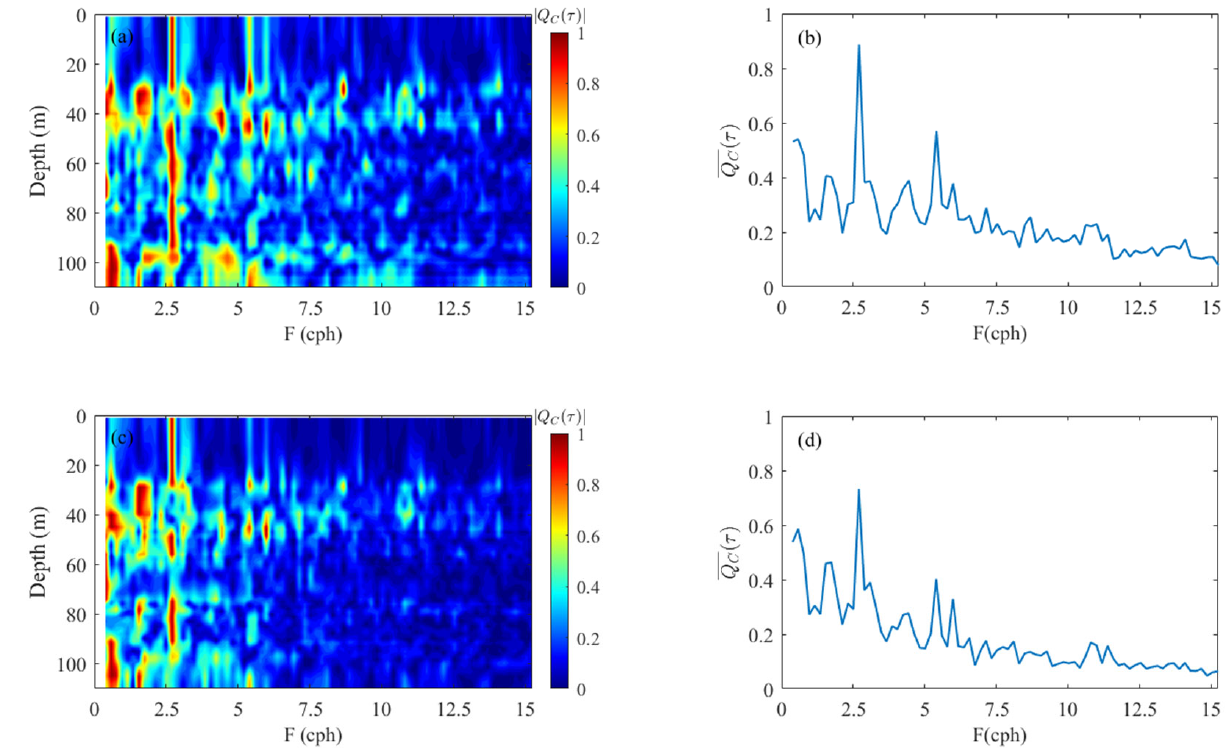
Figure 7. Spectra of C ( t , t + τ ) with different time delays τ : ( a , b ) τ = 2 min and ( c , d ) τ = 8 min. The left panels show contour plots of the normalized spectra | Q C ( τ ) | versus the depth and fluctuation frequency F . The right panels show the curves of depth-averaged spectra Q C ( τ ) versus F .